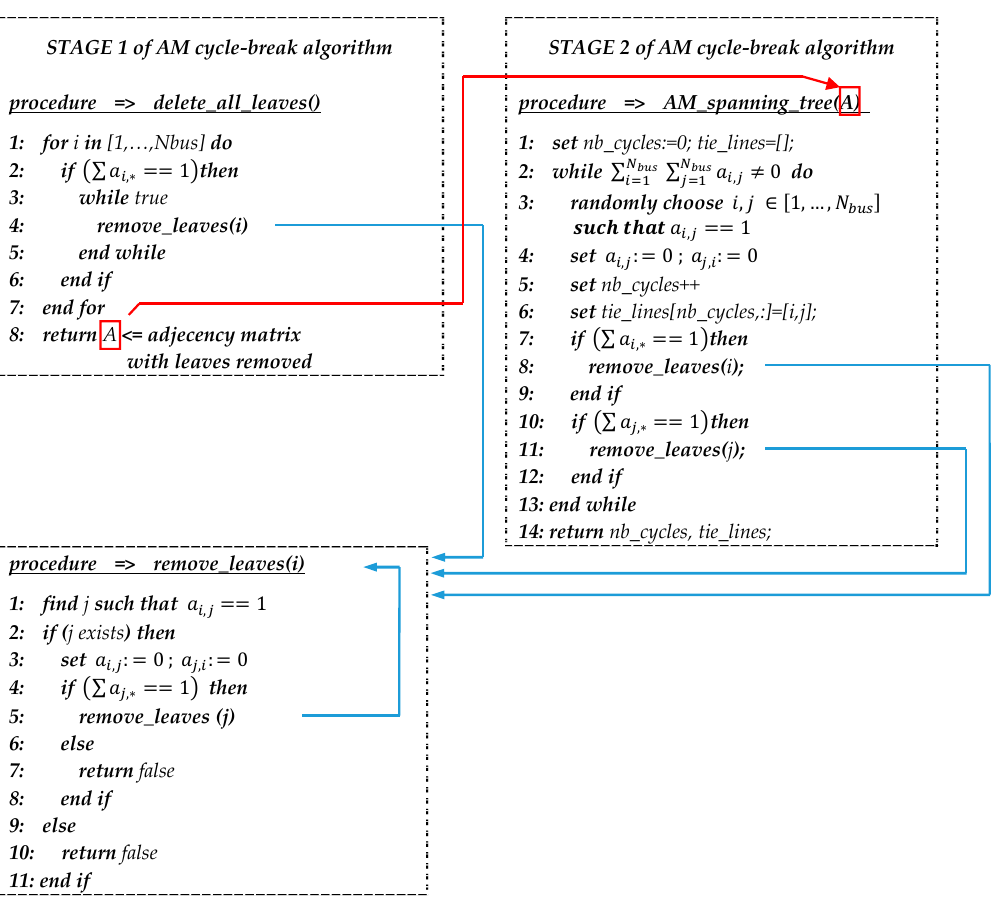
Algorithm 1. Pseudocode for AM cycle break algorithm.